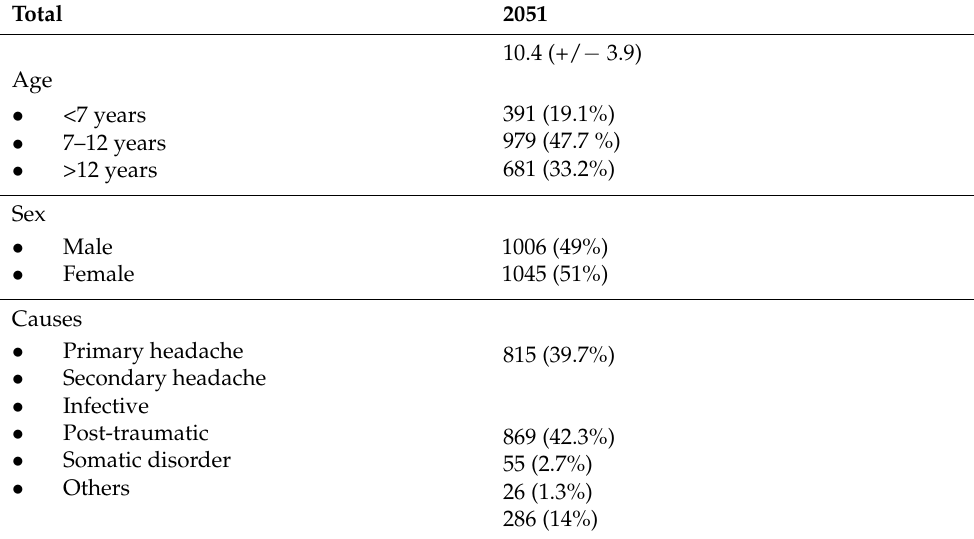
Table 1. General characteristics of the